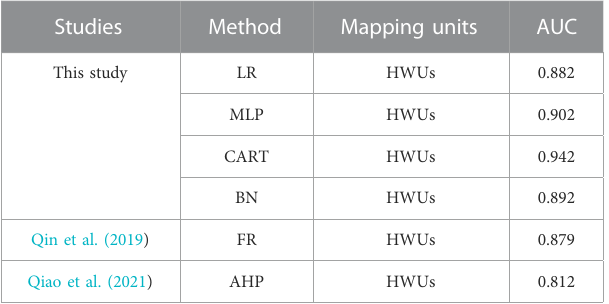
TABLE 5 AUC values of testing data in different